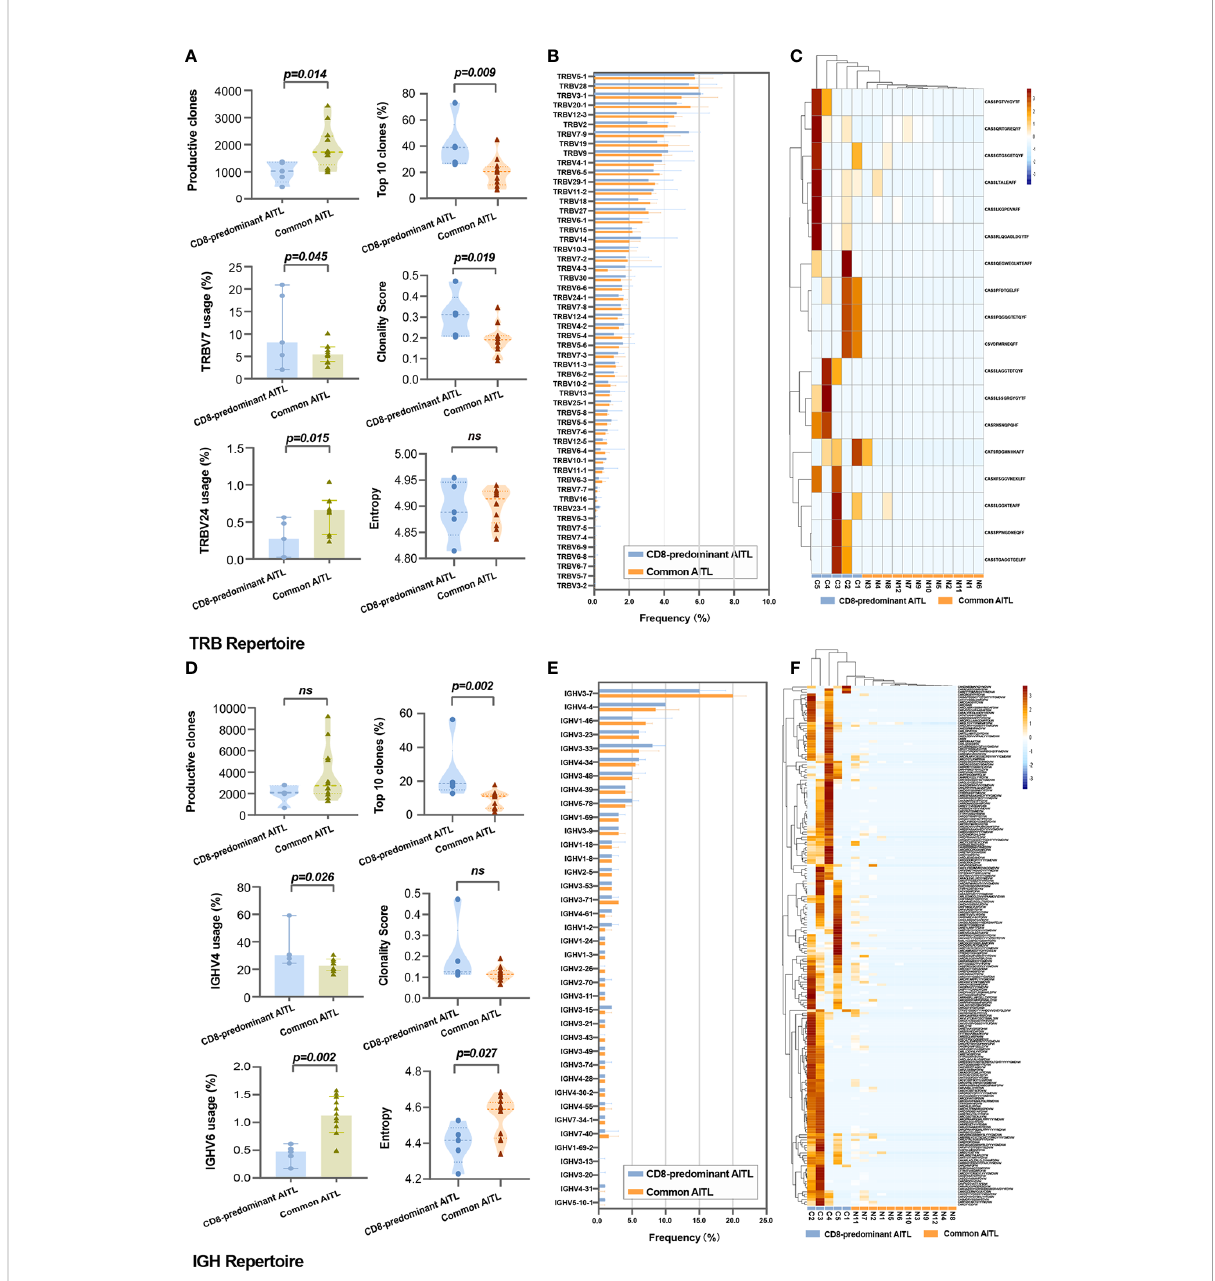
FIGURE 4 Comparison of TRB and IGH repertoires between CD8-predominant AITLs and matched common AITLs. Comparison between two AITL groups TME in statistical metrics including production clones, V-gene family usage, top 10 clones ’ proportion, clonality score, and entropy of TRB repertoire (A) and IGH repertoire (D) , in global usage of V-gene of TRB repertoire (B) and IGH repertoire (E) , and in the CDR3 sequence frequency of the TRB (C) and IGH repertoires (F) . “ ns ” indicates “ no signi fi cance ”